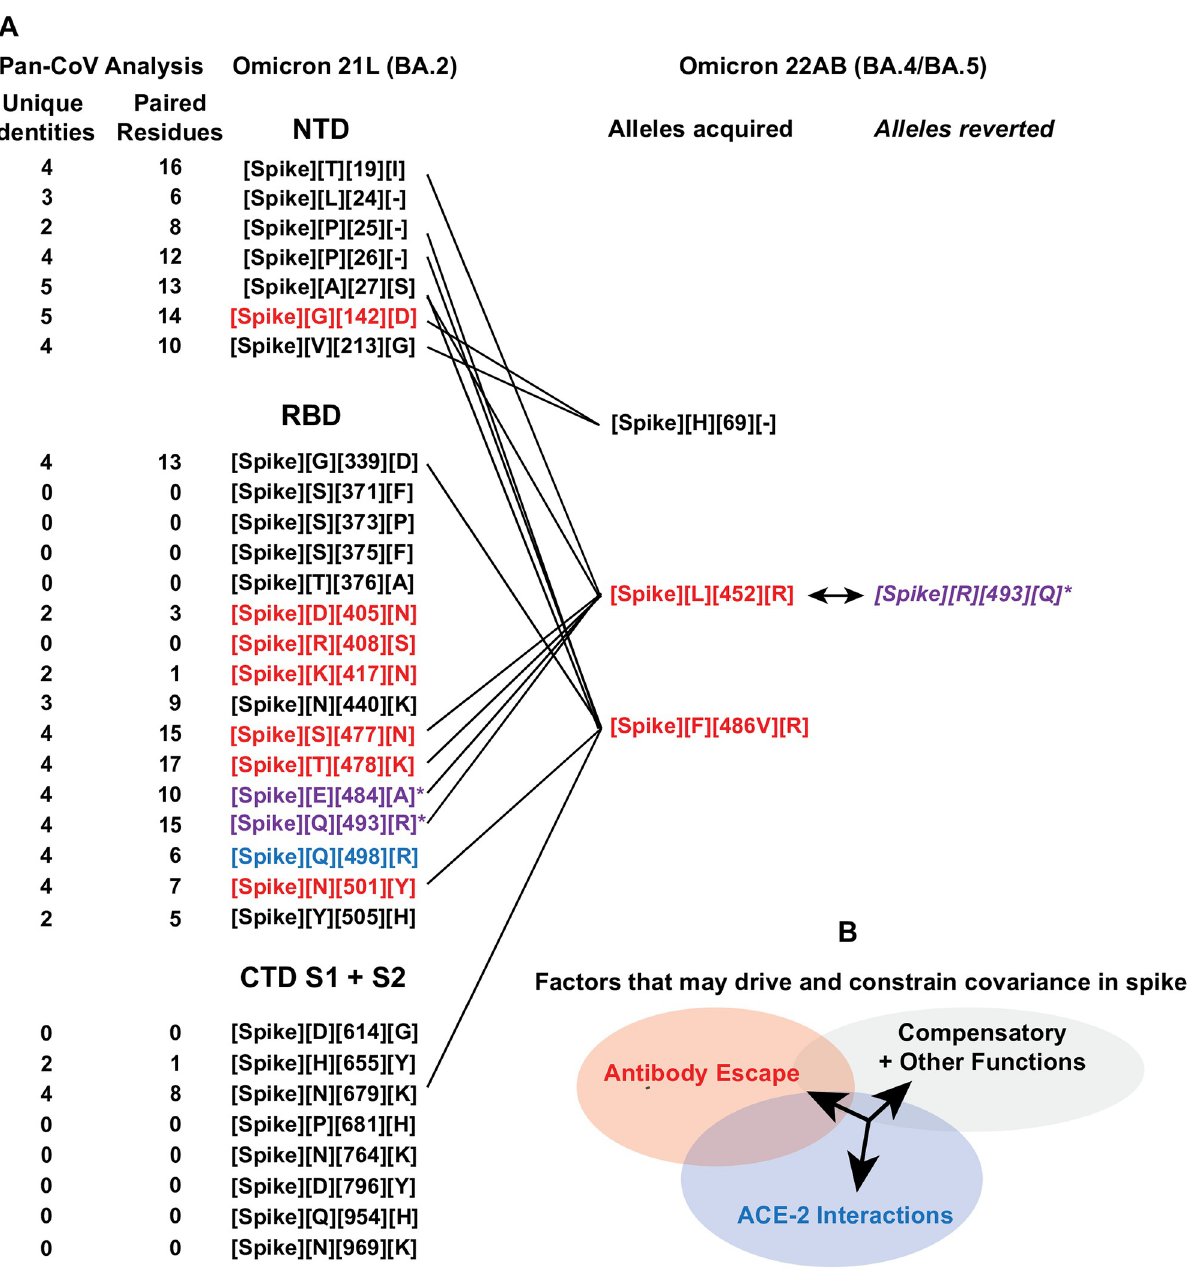
Fig 8. Comparison of spike protein mutations in Omicron 21L and its two emerged sublineages 22A and 22B. (A) Spike mutations are listed as separated by protein subdomain in Omicron 21L and 22A/B. Covariant residues and their respective maximum unique identities and the total number of residues paired within the pan covariance analysis are indicated. Residues that are demonstrated to escape neutralization by antibodies or serum are colored red. Those demonstrated to interact directly with the hACE-2 receptor are colored blue. Those demonstrated to do both are colored purple with an asterisk. New mutations that emerged or instead reverted in 22AB are indicated with covariant linkages to residues in 21L and 22AB. (B) A generalized model showing how mutations and compensatory mutations with varying roles of biological significance may be co-selected based on covariant